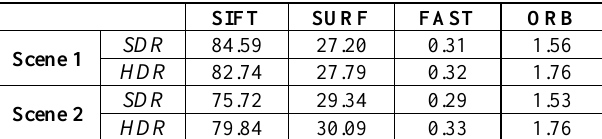
Table 2: Average time needed (in sec.) to detect feature points on SDR and HDR images for both